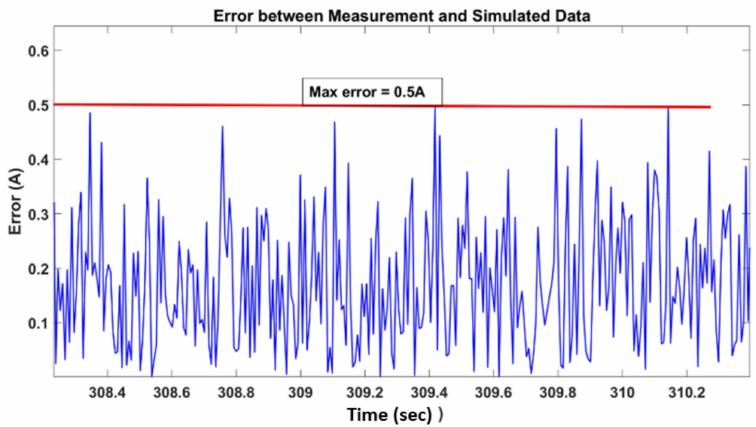
Figure 24. Error between simulated and hardware measurement.